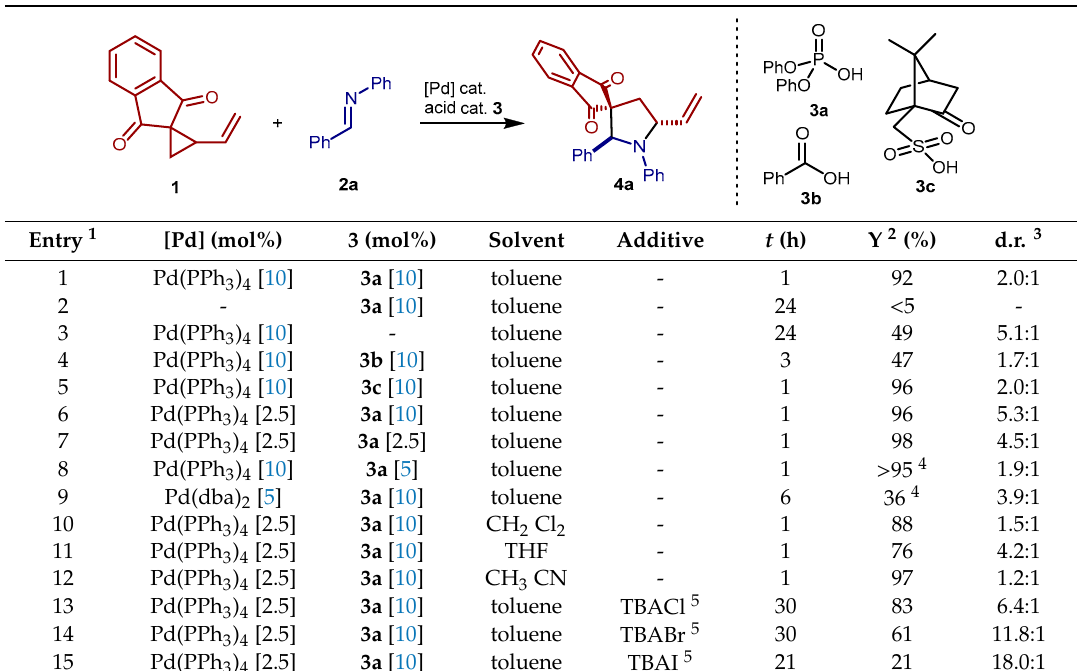
Table 1. Variations of catalysts and reaction conditions in the (3 + 2) cycloaddition between VCP 1 and imine 2a : selected results.